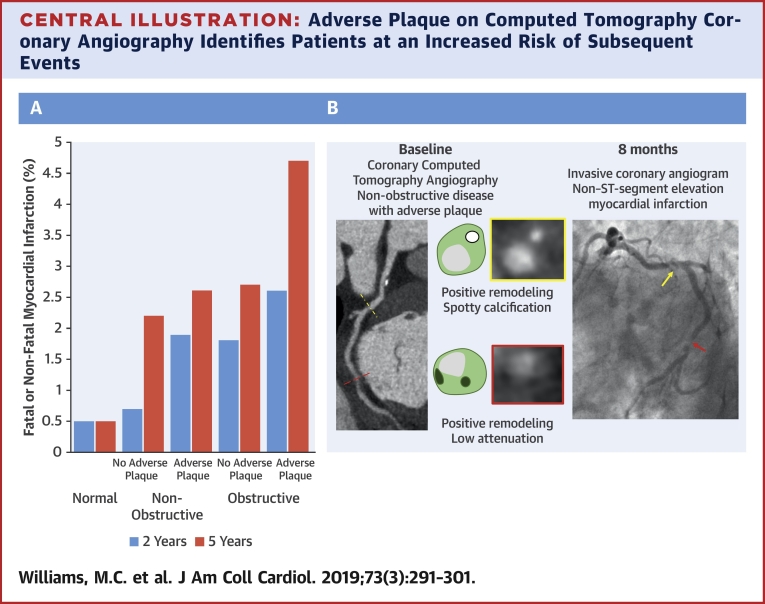
Adverse Plaque on Computed Tomography Coronary Angiography Identifies Patients at an Increased Risk of Subsequent Events(A) Bar graph of the frequency of coronary heart disease death or nonfatal myocardial infarction at 2 and 5 years for patients with normal coronary arteries and nonobstructive or obstructive disease with and without adverse plaque. (B) Coronary computed tomography angiography and invasive coronary angiography images from a patient with nonobstructive coronary artery disease who had a subsequent non–ST-segment elevation myocardial infarction. The red/yellow dotted lines and arrows correspond to the location of the plaques in the red/yellow boxes.